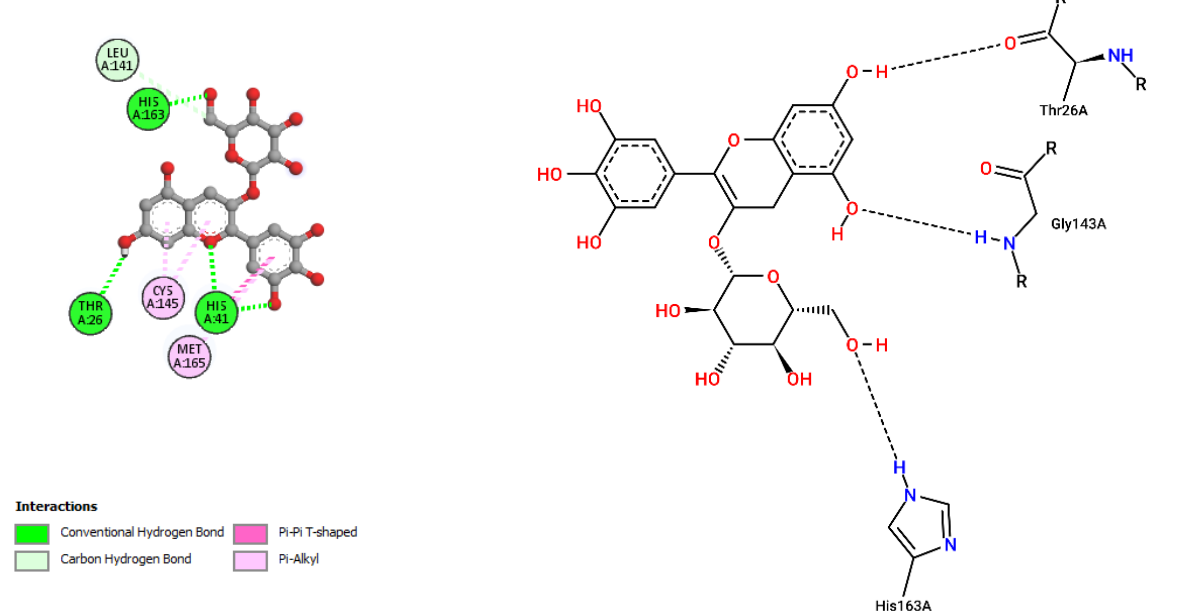
Figure 5. Interaction of delphinidin-3-glucoside with Mpro (without N3). Incanumine interacts with Thr26, His41 , Phe140, Asn142, Gly143 , Glu166 , Pro168, Gln189 , and Ala191 (amino acids important for substrate binding and formation of catalytic dyads are given in bold), that is it interacts primarily with domain 2 of Mpro but also with the catalytic site (His41). Solaradixine interacts with Thr26, His41 , Leu141, Asn142, Ser144 , Cys145 , His164 , Met165 , and Pro168, that is with the catalytic dyad amino acids as well as domain 2 amino acids. Interaction of delphinidin occurs with amino acid residues Leu141, Cys145 , His163 , Met165 , Glu166 , and Gln189 , the amino acids being